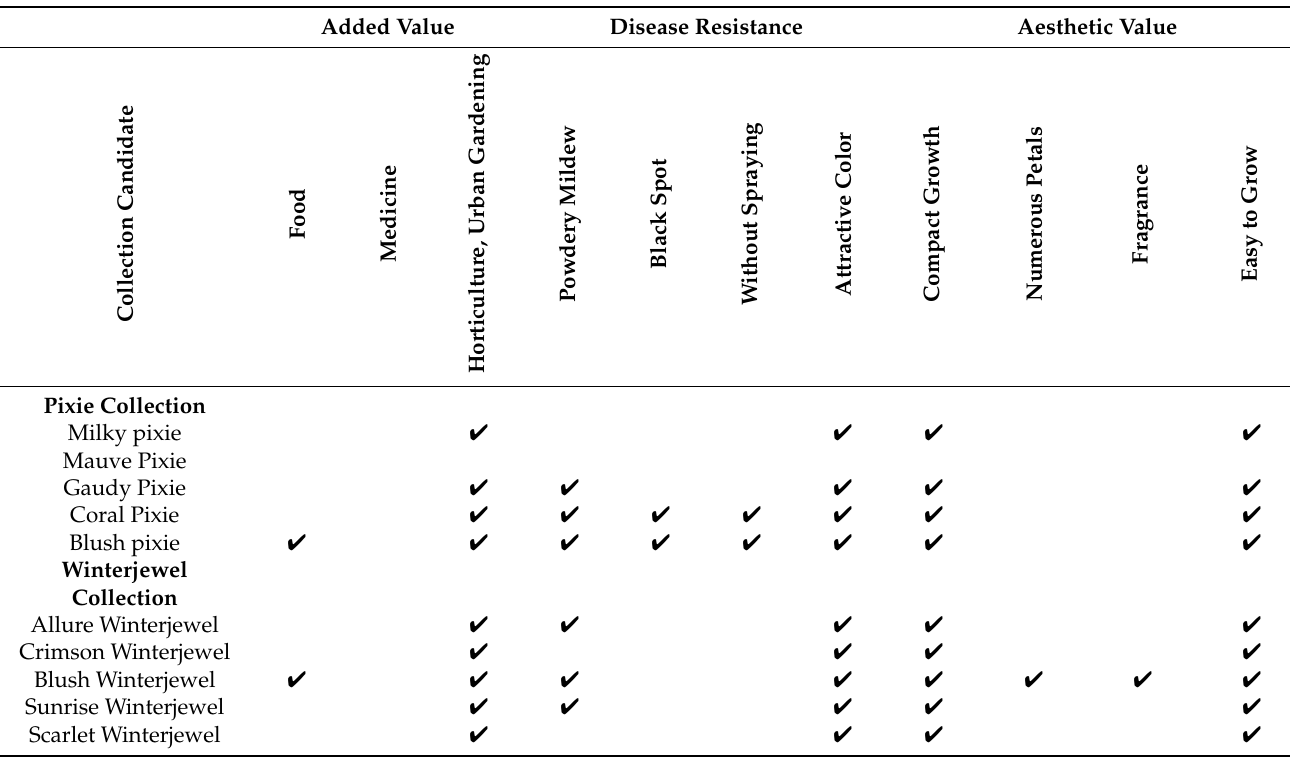
Table 1. Cont. Added Value Disease Resistance Aesthetic